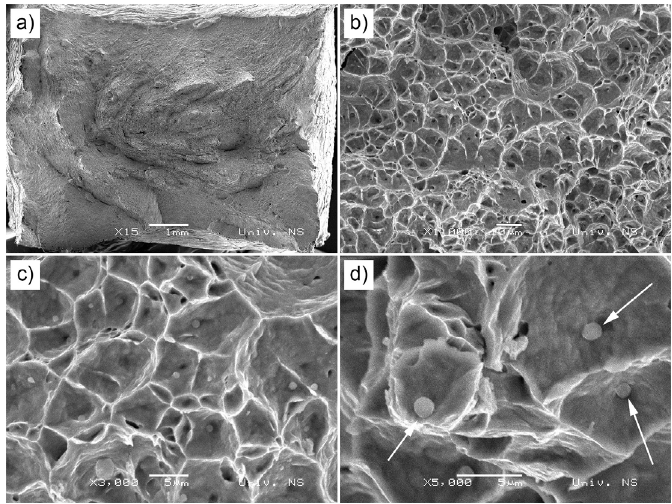
Figure 8. SEM images of fracture surface obtained by tensile testing of the 4Ti1Si specimen: macro image ( a ); micro images showing ductile fracture ( b ); dimples ( c ); dimples with indicated non ‐ metallic inclusions ( d ).